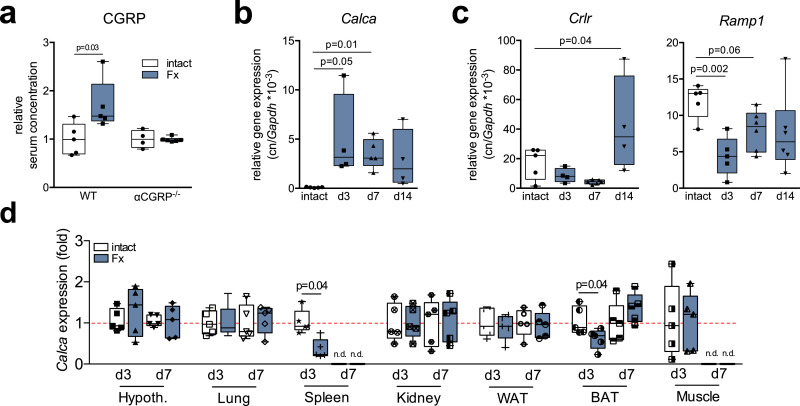
CGRP and CGRP receptor are expressed in the fracture callus on mRNA level. (a) Relative serum CGRP levels in WT and αCGRP-deficient mice with a femoral osteotomy stabilized with an external fixator 14 days post-injury. n = 4–6 mice per group (unpaired student's t-test). (b, c) Gene expression (virtual copy numbers per Gapdh) of the indicated genes in the intact femoral shaft of control animals (intact) and in the fracture callus at the respective time points during bone regeneration (d3, d7, d14). Calca = encoding αCGRP; Crlr = calcitonin receptor-like receptor; Ramp1 = receptor activity-modifying protein 1. n = 4–6 mice per group (one-way Anova followed by Tukey post-hoc test). (d) Calca expression (fold) in the indicated tissues 3 and 7 days following Fx. Hypoth. = hypothalamus; WAT = white adipose tissue; BAT = brown adipose tissue; n.d. = not detectable. The dotted red line indicates average expression of respective, untreated control tissues. n = 3–5 mice per group (unpaired student's t-test). For (a-d), box plots represent median with minimum and maximum whiskers. Controls are untreated mice of the same sex and age.